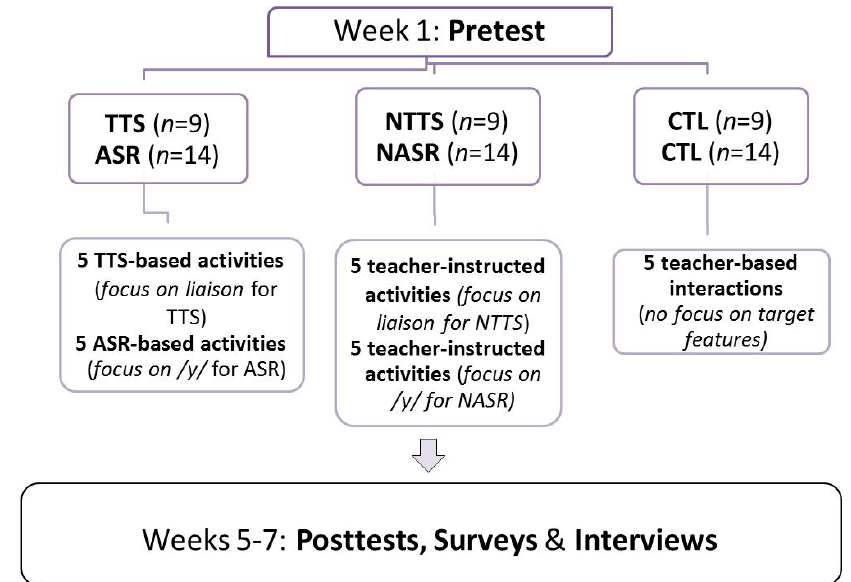
Figure 2. Design of the study. TTS = Text ‐ to ‐ Speech Group; NTTS = Non ‐ TTS Group (teacher ‐ led); ASR = Automatic Speech Recognition group; NASR = Non ‐ ASR group (teacher ‐ led); CTL = Control Group.